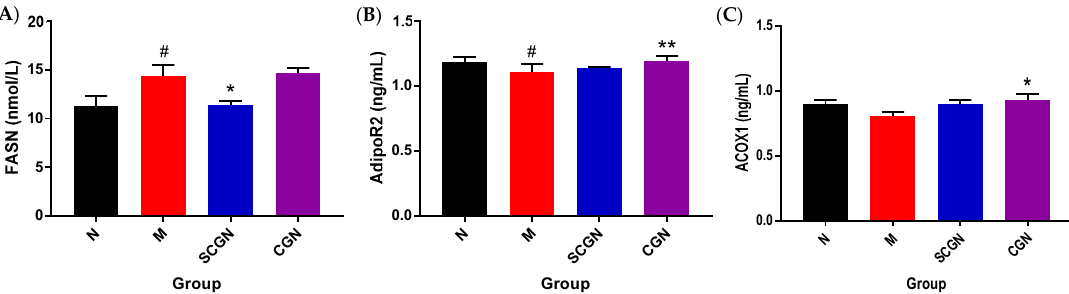
Figure 5. Protein levels of selected genes with significant changes in mRNA expressions: ( A ) fatty acid synthase (FASN), ( B ) AdipoR2, and ( C ) ACO hepatic levels. Values are given as mean ± SEM, n = 5. Statistical significances were calculated using two-way ANOVA with Dunnett post-test (* p < 0.05, ** p < 0.01); # denotes versus N, * denotes versus M.